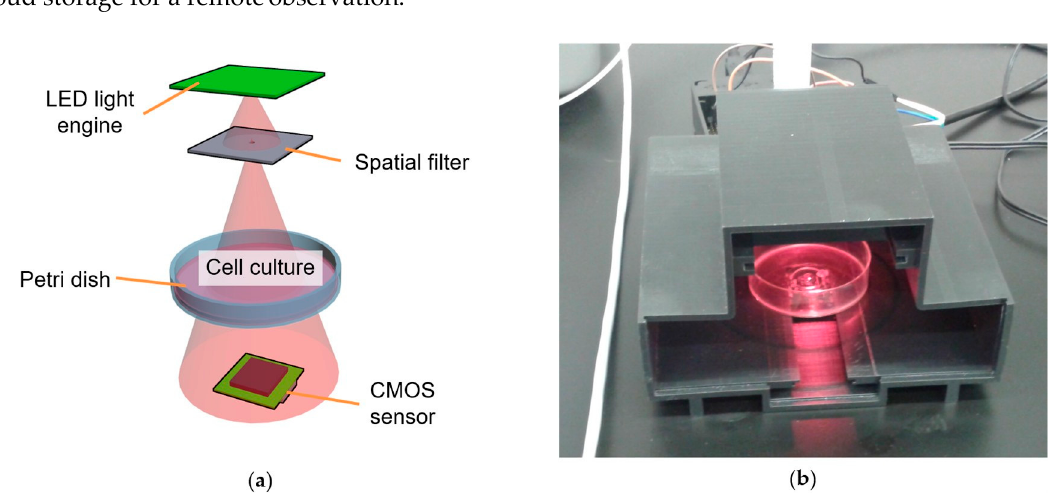
Figure 1. Portable lensless digital-holographic imaging device for real-time cell culture monitoring: ( a ) schematic drawing of the measurement principle and ( b ) picture of the imaging setup with 3D printed mechanical